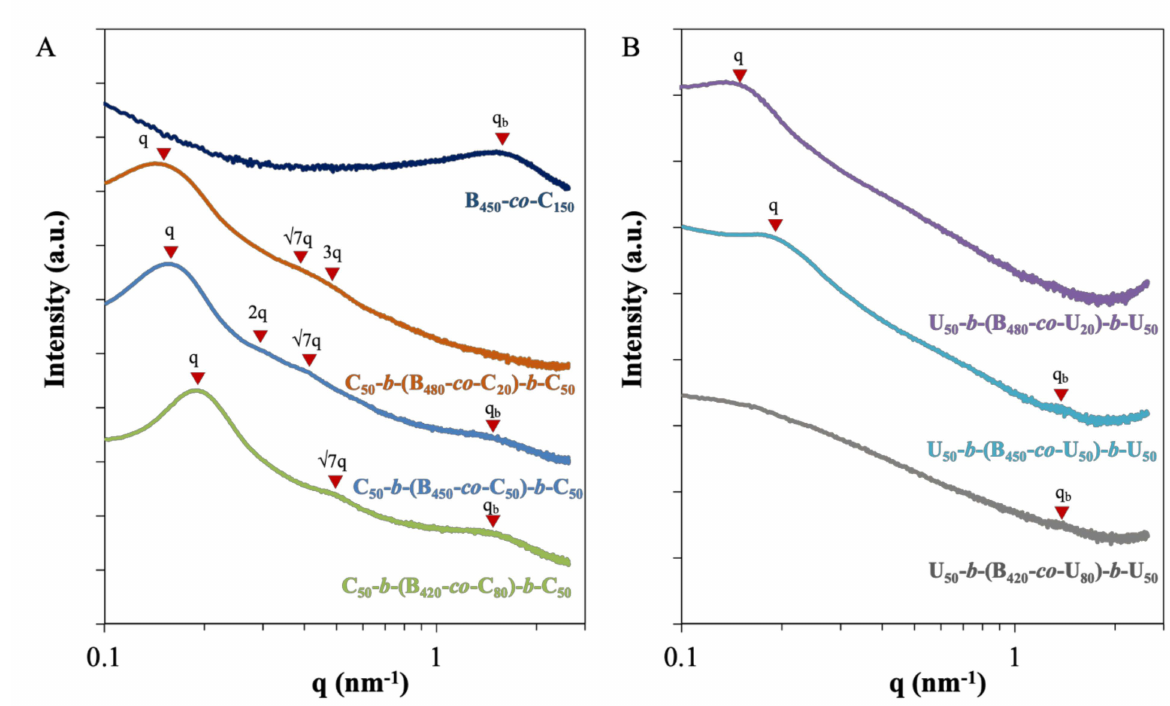
Figure 5. SAXS of solution casted ( A ) CyA and ( B ) UCyA triblock copolymer films with varied amounts of hydrogen bonding unit. Curves are shifted vertically for